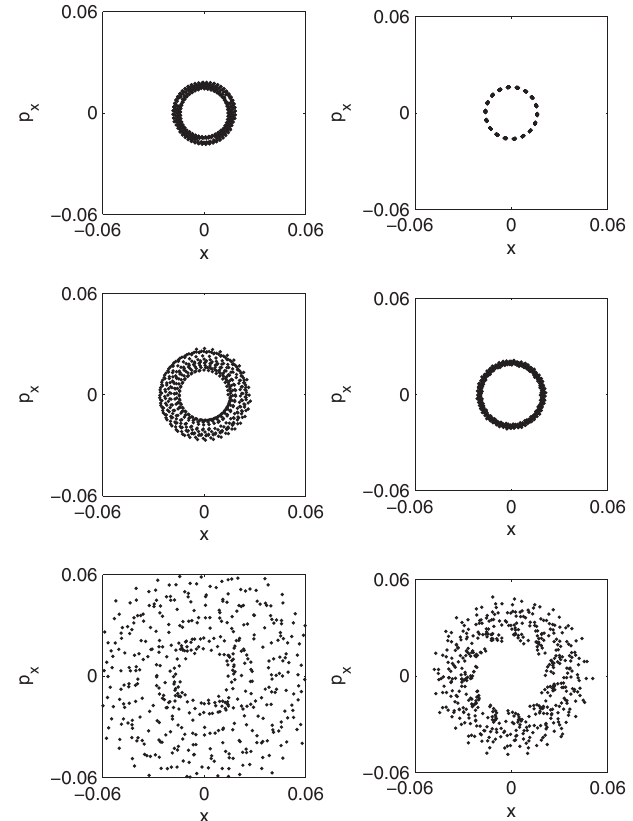
FIG. 3. Effect of normalizing and turn-dependent decoupling transformation on the horizontal phase space with different initial vertical amplitudes. The initial horizontal action is 10 (cid:6) 4 in each case. The plots on the left show the phase space with the original map, Eq. (7), applied 1000 times. The plots on the right show the phase space with both the normalizing transformation, Eq. (5), and the turn-dependent decoupling transformation, (cid:1) 0 : 08 . Middle: initial J (cid:1) Eq. (7), applied. Top: initial J y y (cid:1) 0 : 27 . 0 : 16 . Bottom: initial J y